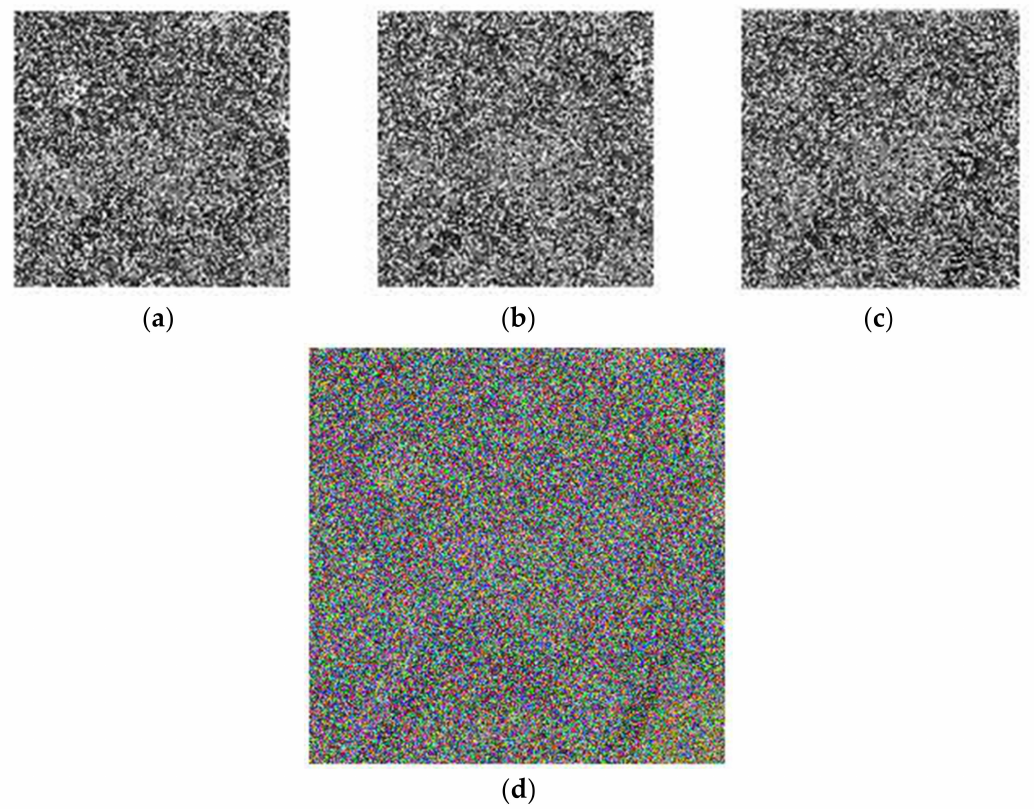
Figure 9. Experimental data: ( a – c ) corresponding decrypted image of 30th, 70th and 100th band with O = “1324”; ( d ) decrypted image combined of ( a – c ).